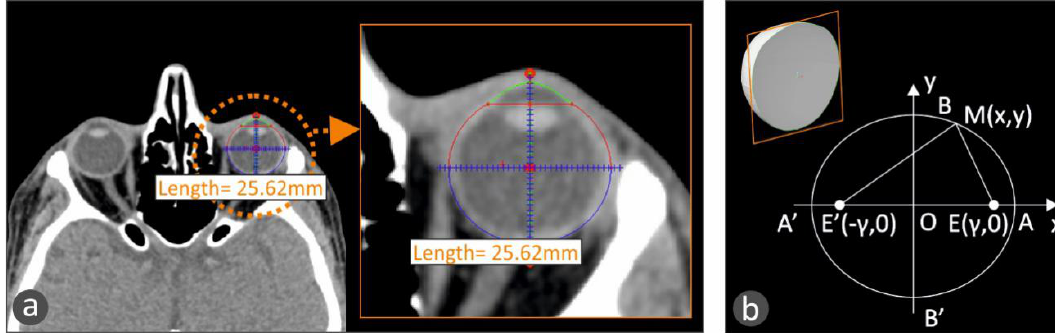
Figure 2. ( a ) Fitting an ellipse in the human eye circumference to more accurately capture the eye geometry in a CT scan image with the developed methodology. ( b ) The ellipse geometry that the human eye follows, according to human anatomy [16].